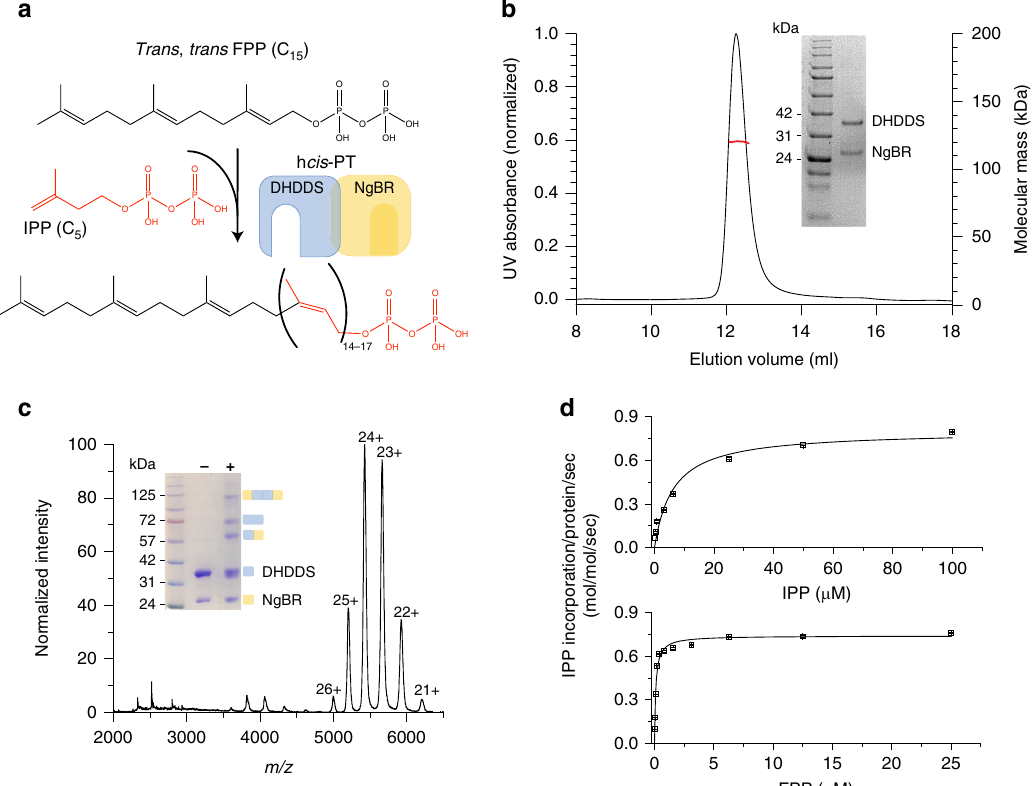
Fig. 1 Complex stoichiometry and functional analysis of sh cis -PT. a Dehydrodolichyl diphosphate synthesis reaction scheme. The IPP moiety is colored red. The h cis -PT subunits DHDDS and NgBR are schematically drawn and colored blue and yellow, respectively. b Representative SEC-MALS analysis of the puri fi ed sh cis -PT. The black and red curves indicate UV absorption and molecular mass, respectively. The experiment was performed twice using two different protein batches. Inset: SDS-PAGE analysis of the puri fi ed complex. Left lane: molecular weight marker, right lane: puri fi ed sh cis -PT. Molecular weights (kDa) are indicated. Source data are provided as a Source Data fi le. c Native ESI-MS spectrum obtained using low activation conditions. The main distribution corresponds to the heterotetramer (charge states 21 – 26). Inset: SDS-PAGE analysis of the complex following glutaraldehyde cross-linking. Left lane: molecular weight marker, middle lane: puri fi ed sh cis -PT without glutaraldehyde, and right lane: puri fi ed sh cis -PT with glutaraldehyde. Molecular weights (kDa) are indicated. The experiment was performed twice using two different protein batches. The oligomeric state represented by each state is illustrated using the schematic presentation from panel ( a ). Source data are provided as a Source Data fi le. d In vitro activity of puri fi ed sh cis -PT assessed as IPP incorporation. Experiments were performed as described in the “ Methods ” section. Data are presented as mean ± SEM ( n = 3 independent experiments). Source data are provided as a Source Data fi